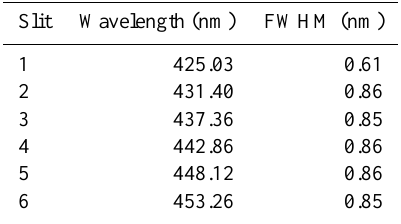
Table 1. Measuring wavelengths and resolutions, expressed in terms of full width at half maximum (FWHM), of Brewer #001 corre- sponding to the default grating position in n2